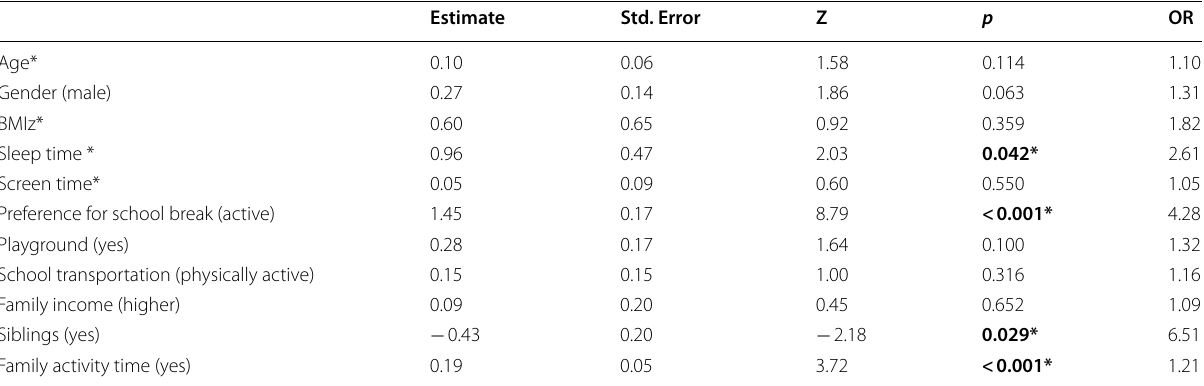
*Continuous variable AIC: 1204.3